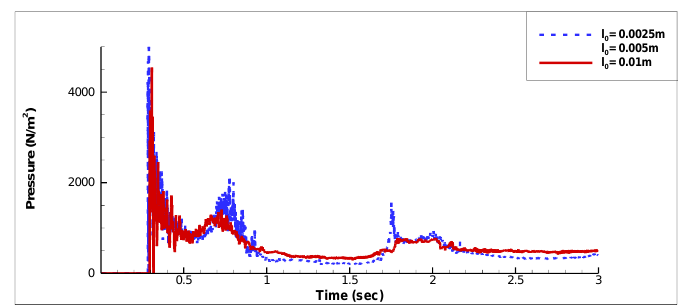
Figure 5. Convergence test for the initial particle distance.